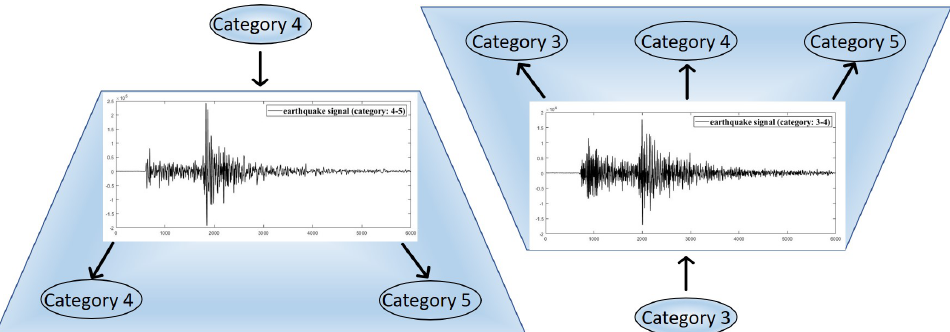
Figure 1. Multiclass to multi-label data transformation: examples of converted multiclass earthquake categories to multi-label categories. An earthquake signal first belongs to a single category. However, after transformation, it belongs to multiple